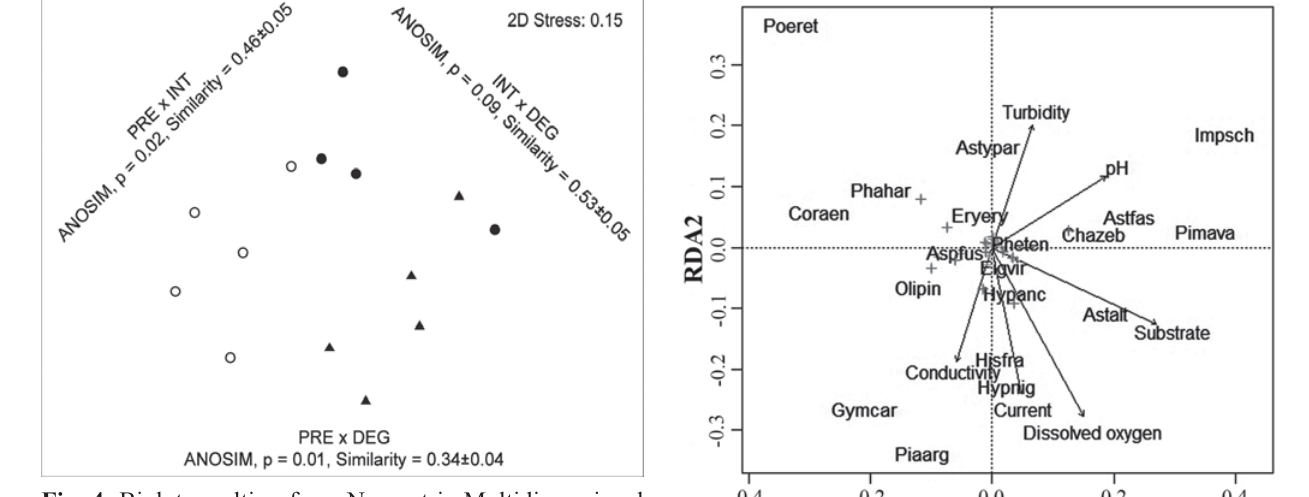
Fig. 4. Biplot resulting from Nonmetric Multidimensional Scaling Analysis (NMDS) with presence and absence data showing ordination of sample units that represent each stream group: preserved (PRE, open circles), intermediate (INT, dark circles), and degraded sites (DEG, triangles). NMDS biplot exhibited stress value of 0.15 in 2-dimension, indicating good to potential useful interpretation (Clarke & Warwick, 2001).